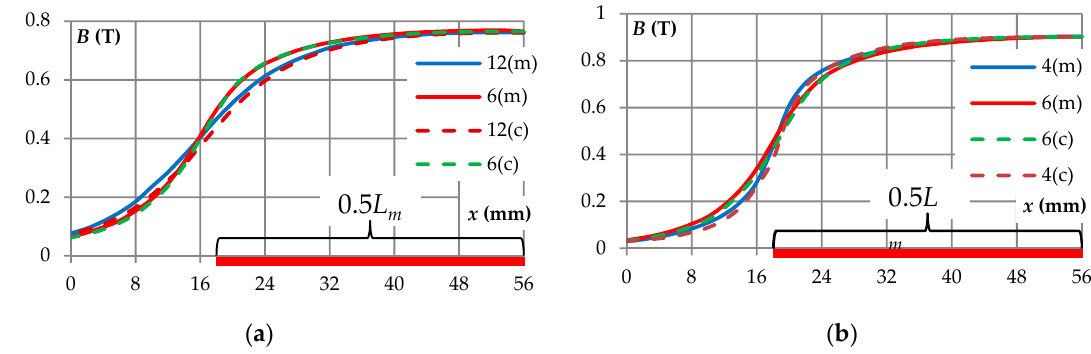
Figure 10. System for measuring the magnetic flux density in the exciter gap ( a ); 1—exciter, 2—probe shift system, 3— gaussometer, 4—probe, 5—guides for moving the MCM sample, 6—elements of the temperature stabilization system; diagram of the probe orientation and movement between the exciter magnets ( b ).